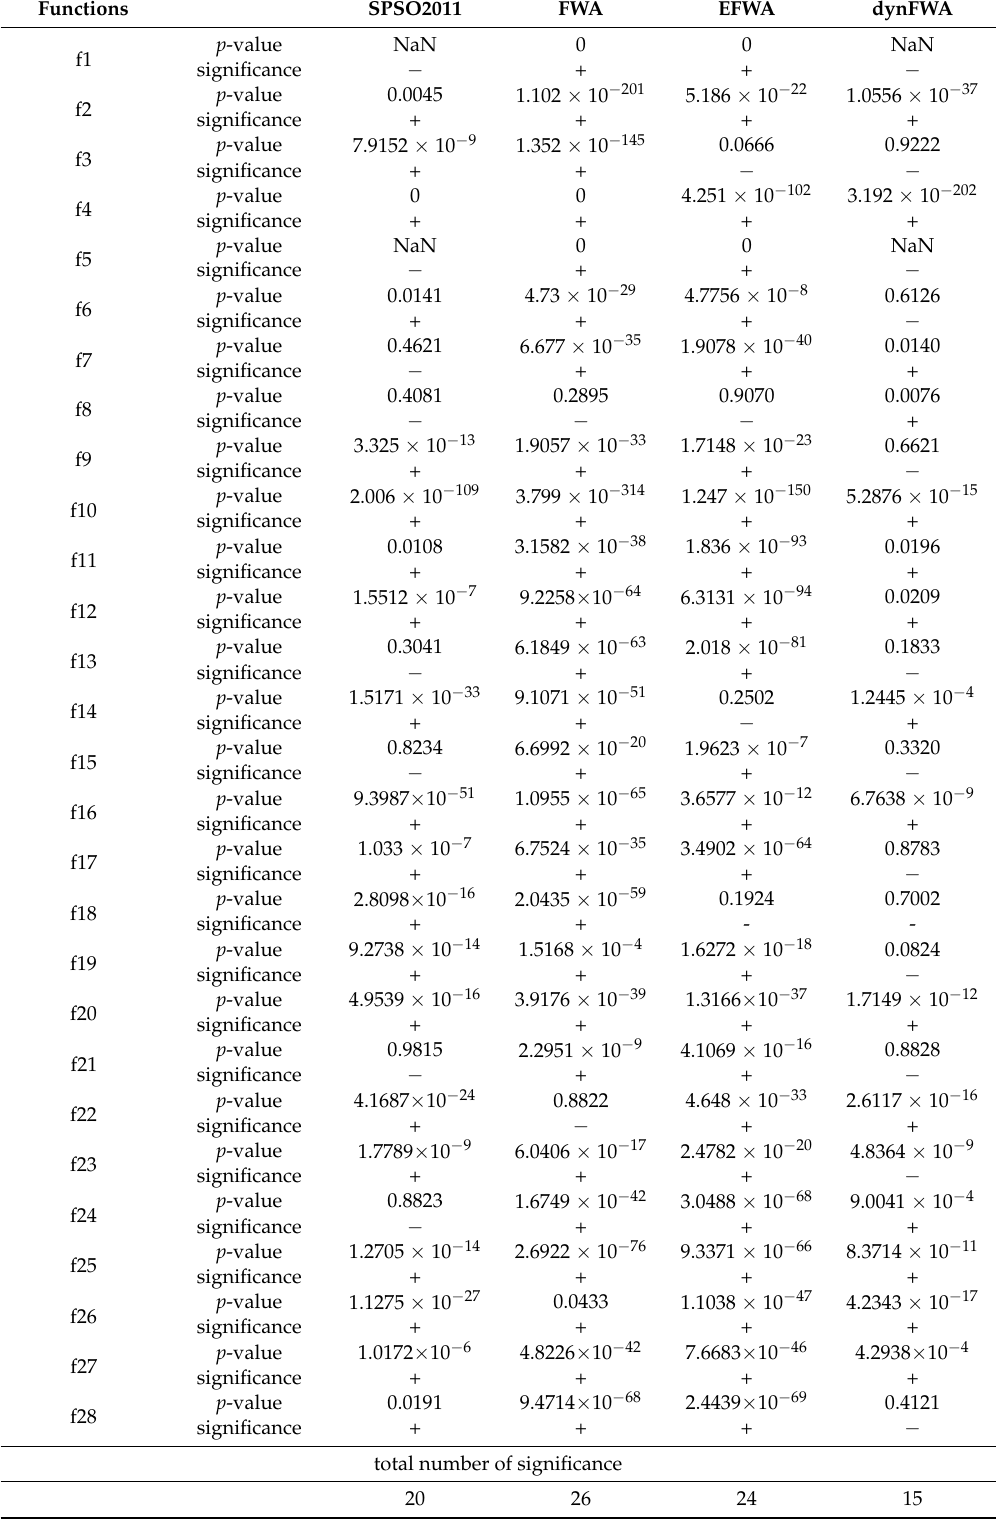
Table 4. T test results of IFWA compare with SPSO2011, FWA, EFWA, dynFWA.